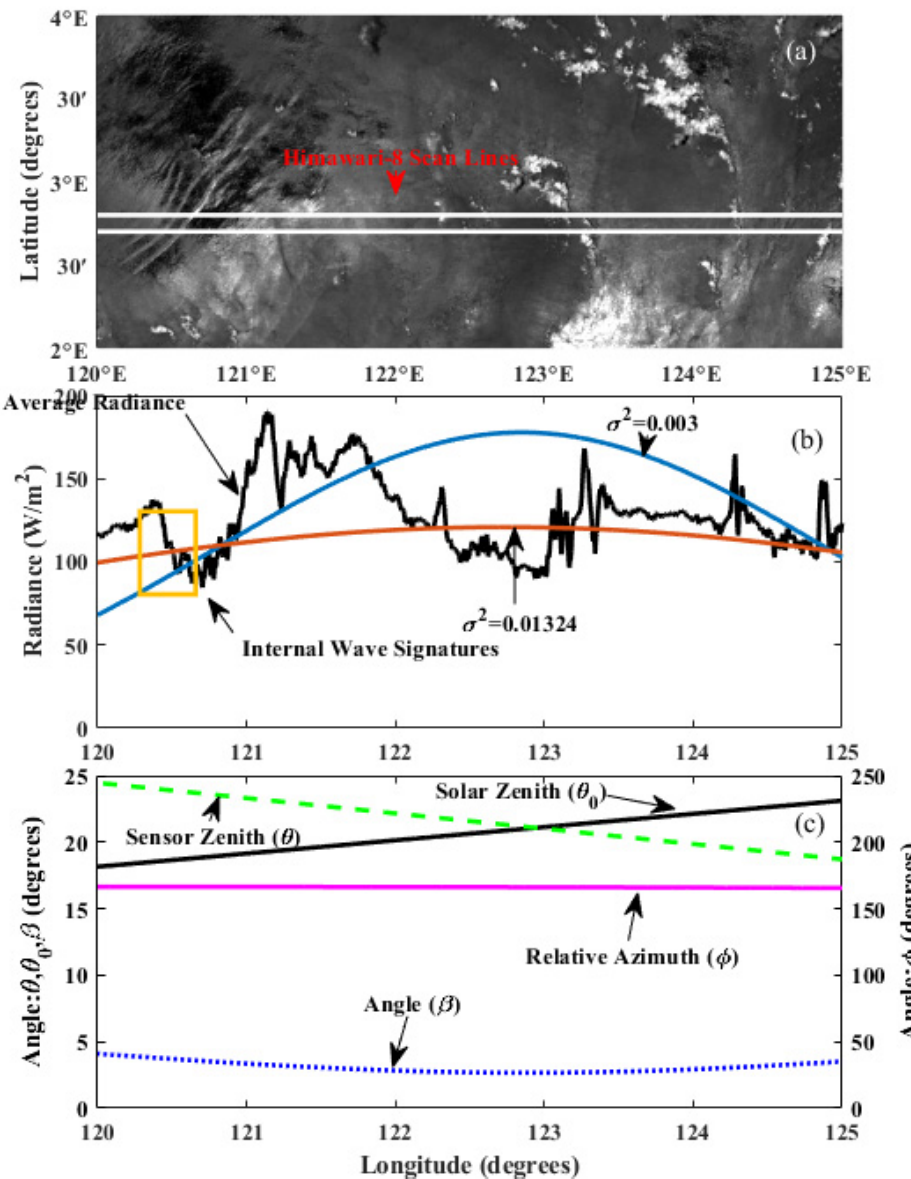
Figure 8. Analysis of the image acquired on 21 September 2020 at 05:00 UTC. ( a ) shows part of the Himawari-8 image of the Celebes Sea acquired on 21 September 2020 at 05:00 UTC, and the white solid line indicates the scan line of the AHI sensor onboard the Himawari-8 satellite; ( b ) shows curves of the normalized solar radiance calculated with roughness variance ( σ 2 ) values of 0.003 and 0.01324 and the average measured radiance along the scan line, and the yellow box marks the position of the internal solitary waves. The blue and orange curves represent the radiance information of the sea surface background and internal solitary waves, respectively; ( c ) shows the changes in the solar zenith angle ( θ 0 ), sensor zenith angle ( θ ), relative azimuth angle ( ϕ ), and surface facet tilt ( ꞵ ) along the AHI sensor scan line. The solid black line represents the change in the solar zenith angle ( θ 0 ) along the scan line. The green dashed line represents the change in the sensor zenith angle ( θ ) along the scan line. The purple solid line represents the relative azimuth angle ( ϕ ) along the scan line. The blue dotted line represents the change in the surface facet tilt ( ꞵ ) along the scan line.